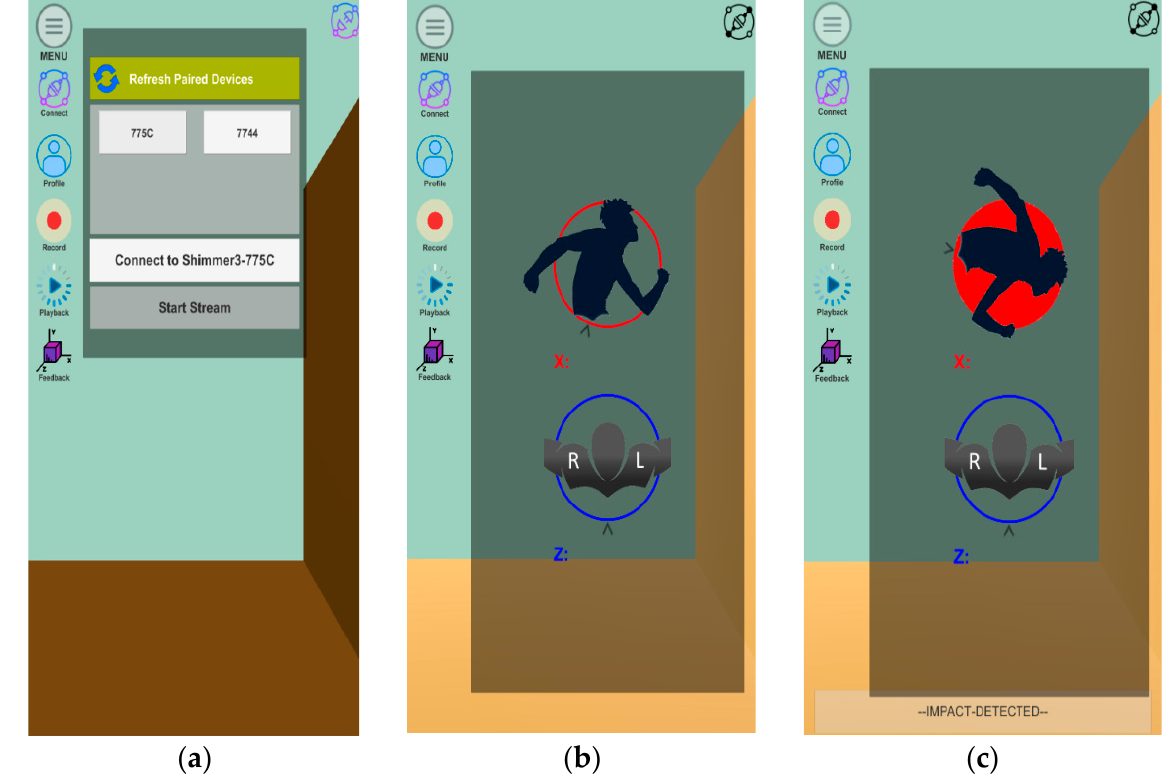
Figure 2. ( a ) Mobile application connecting to the inertial measurement unit (IMU); ( b ) calibrating IMU to the participant; and ( c ) modelling an unsafe tackle indicated by the ‘red light’ display .